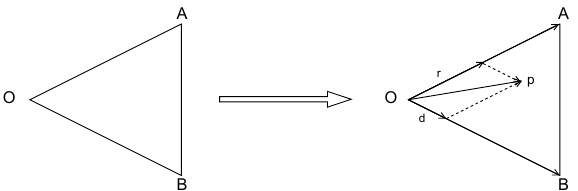
Figure 2. Random point re-sampling based on triangular